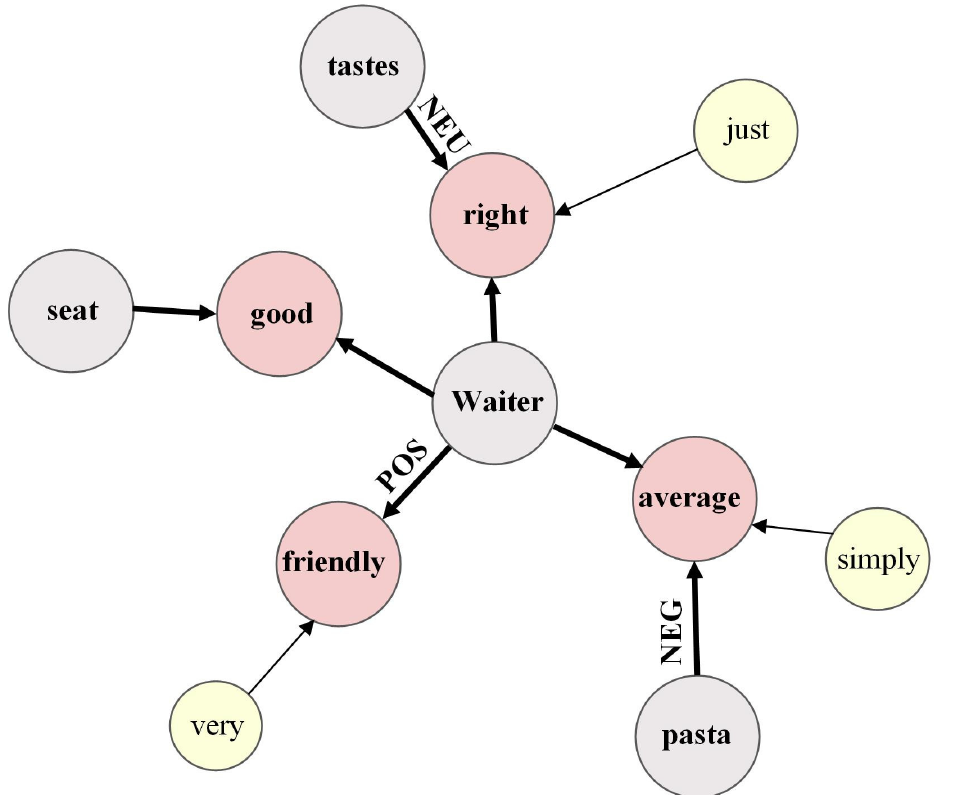
Figure 2. Heterogeneous graph of “aspect word, sentiment polarity, sentiment